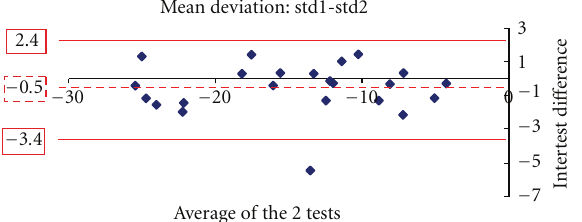
Figure 4: The Bland-Altman plot showing agreement in number of depressed points at least at P < 2% between the first visit 10- 2 SITA-standard and SITA-fast tests. The dashed line marks the average di ff erence between the two algorithms. The solid lines mark the upper and lower limits of the 95% limits of agreement.